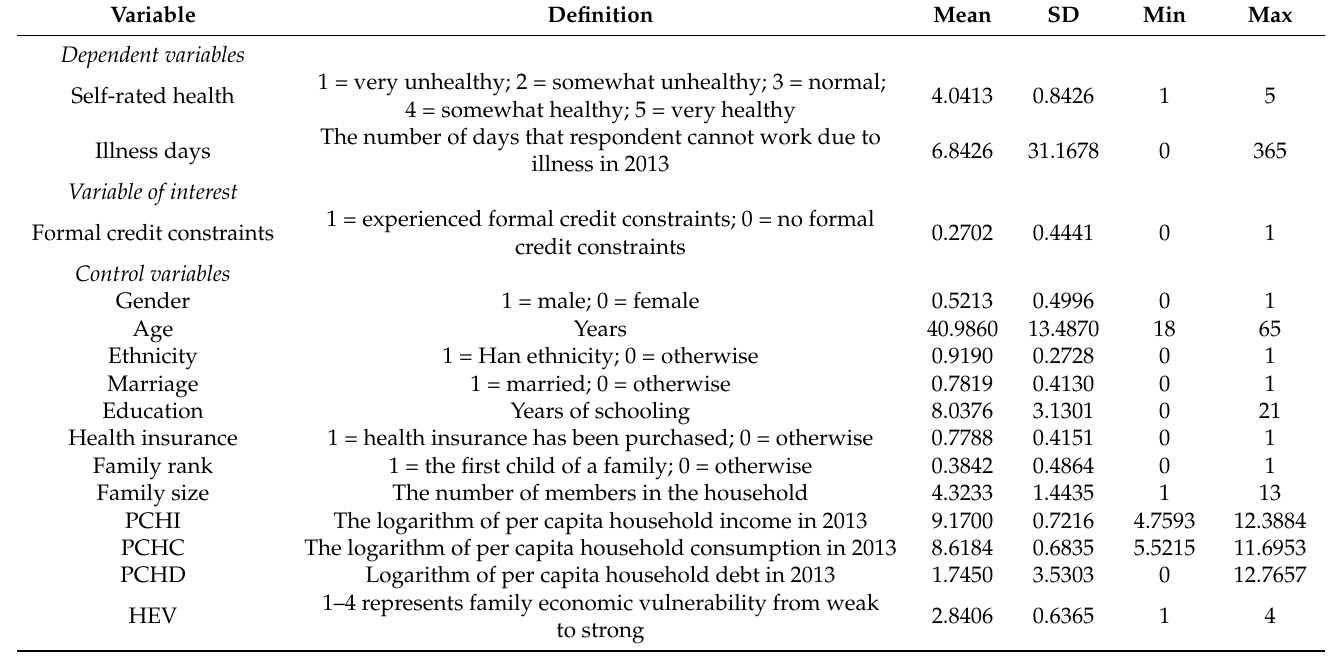
Table 1. Definition of variables and descriptive statistics ( n = 21,991).